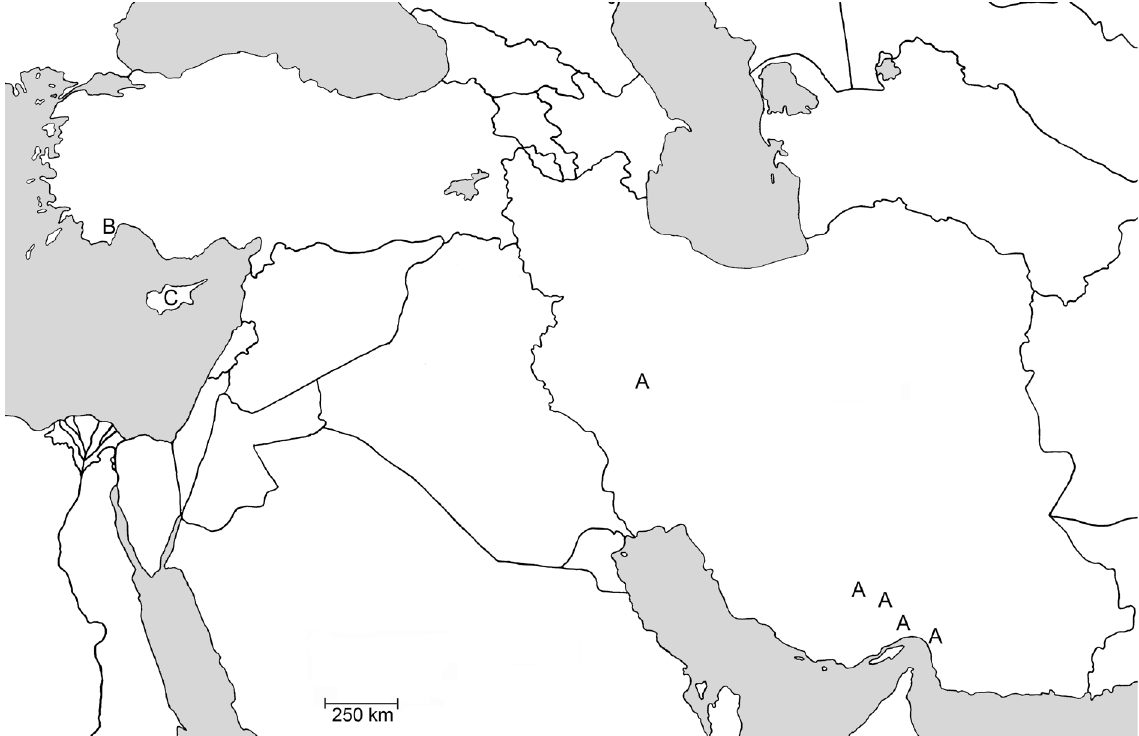
Fig. 3. Distribution of Brachypsectra in the Palaearctic Region. A = B. kadleci Hájek, 2010; B = B. jaechi sp. nov.; C = Brachypsectra sp. from